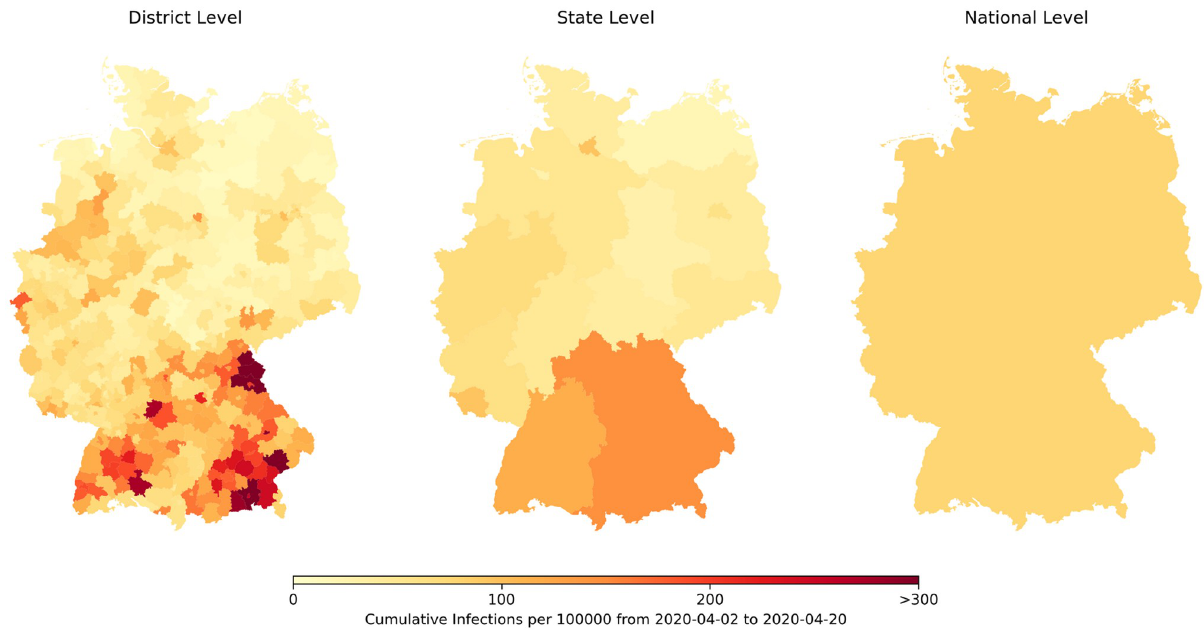
Fig 2. Cummulative reported COVID-19 cases on different hierarchical levels. The number of laboratory confirmed COVID-19 cases per 100000 accumulated from the second NPI on 2020–04-02 until the third NPI on 2020–04-20 on three different spatial resolutions according to the hierarchical administrative divisions of Germany. Borders republished from [32] under a CC BY licence, with permission from GeoBasis-DE / BKG, original copyright 2019. © GeoBasis-DE / BKG